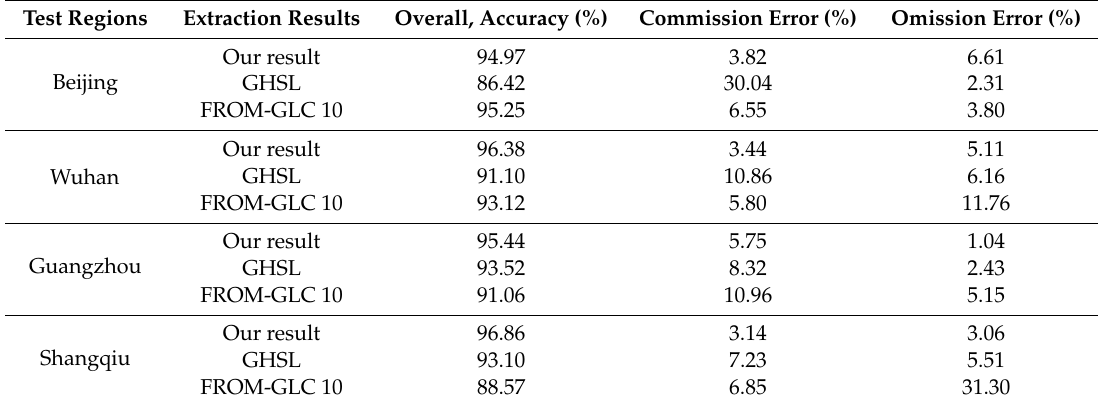
Table 5. Accuracy comparison of our results and optical products.